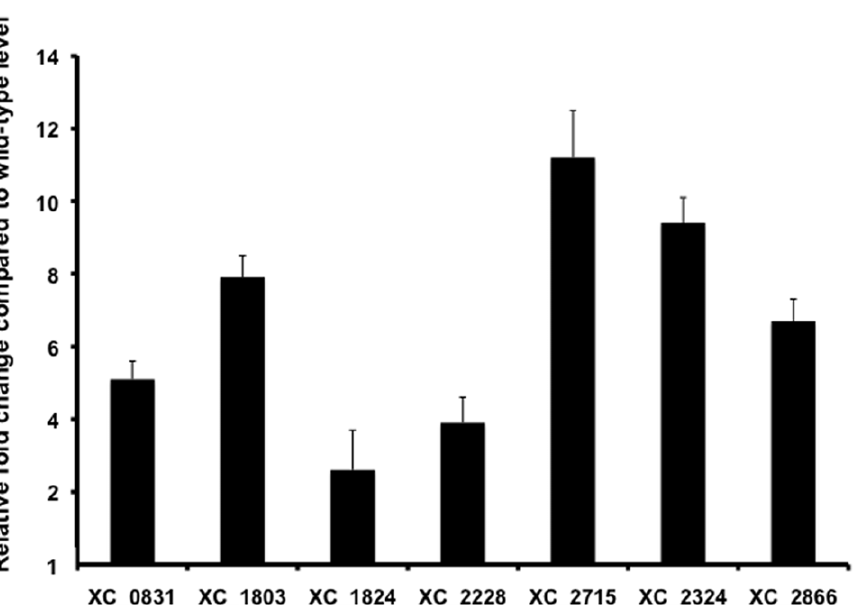
Figure 2. RsmA regulates the expression of genes encoding GGDEF and GGDEF/EAL domain proteins in Xanthomonas. Transcript levels of all genes encoding GGDEF, EAL or HD-GYP were measured in wild-type strain (8004) and rsmA mutant backgrounds by qRT-PCR. Bacterial strains were grown to an OD at 600 nm of 0.8 in complex medium before RNA extraction. All qRT-PCR results were normalized using the Ct s obtained for the 16S rRNA amplifications run in the same plate. The relative amounts of gene transcripts were determined from standard curves. Only the results from those genes ( XC_0831, XC_1803, XC_1824, XC_2228, XC_2324, XC_2715 and XC_2866 ) showing significant differences between the wild type and rsmA mutant are shown. Values given are the mean and standard deviation of triplicate measurements (three biological and three technical replicates). Similar differences were also seen when the bacteria were harvested at an OD at 600 nm of 1.0 and 1.5 (data not shown).